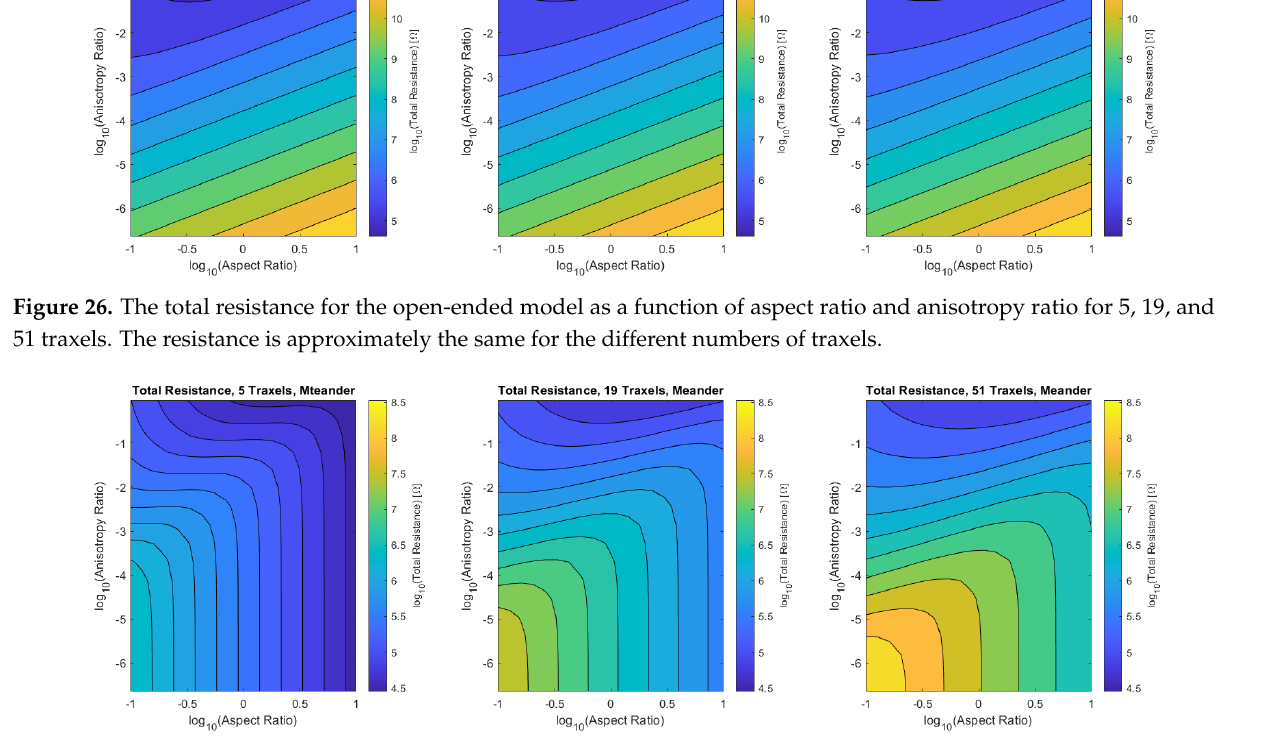
Figure 27. The total resistance for the meandering model as a function of aspect ratio and anisotropy ratio for 5, 19 and 51 traxels. The resistance shows the same qualitative behavior for the different numbers of traxels with a shift in